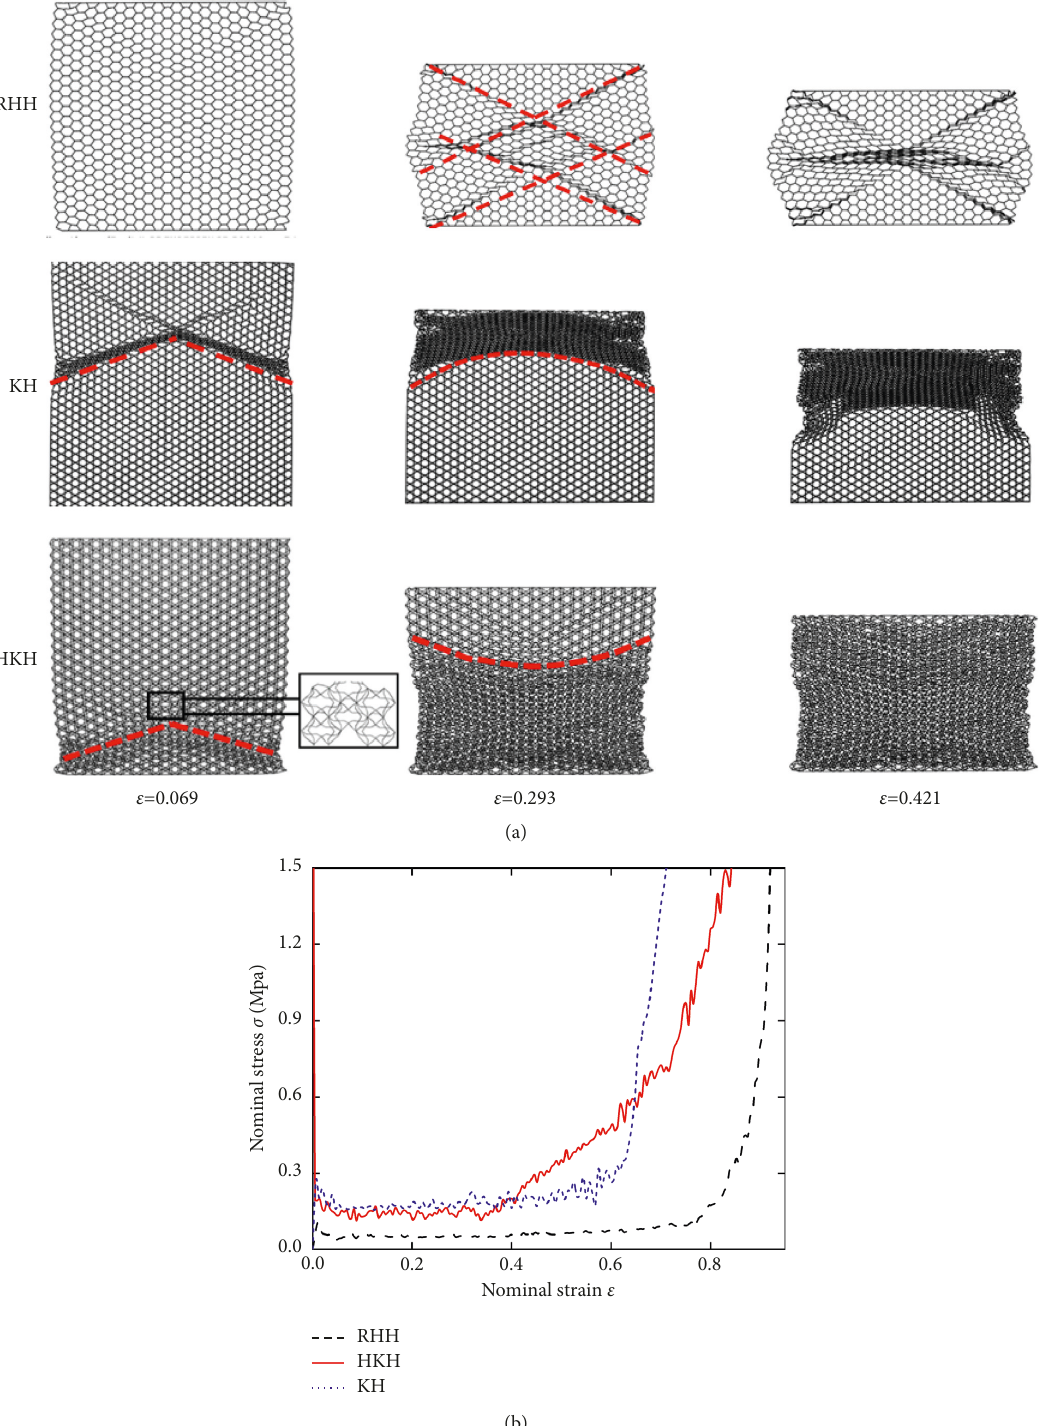
Figure 5: Dynamic crushing behaviors of three honeycombs under an impact velocity of V � 3m/s: (a) deformation maps and (b) strain- stress